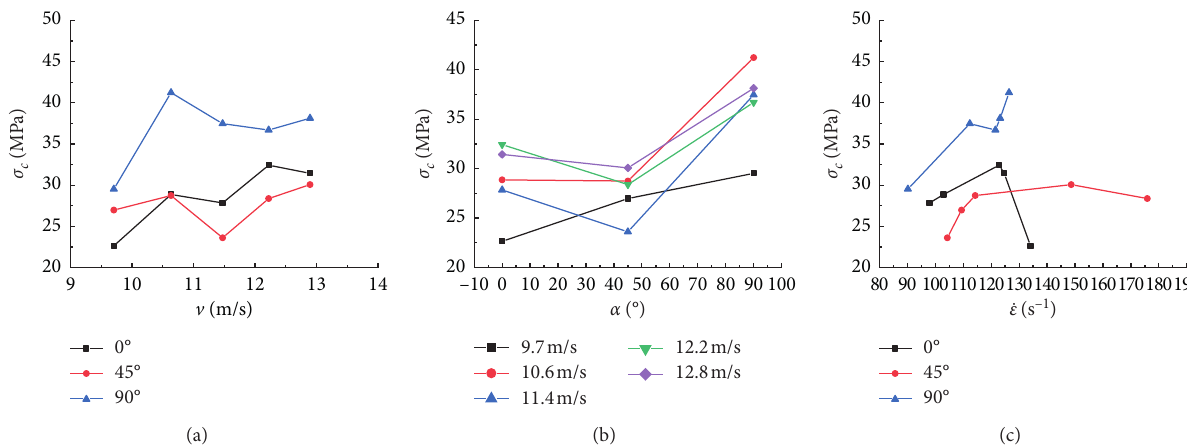
Figure 13: Relationship curve between crack initiation stress and loading rate, prefabricated fracture angle, and strain rate.